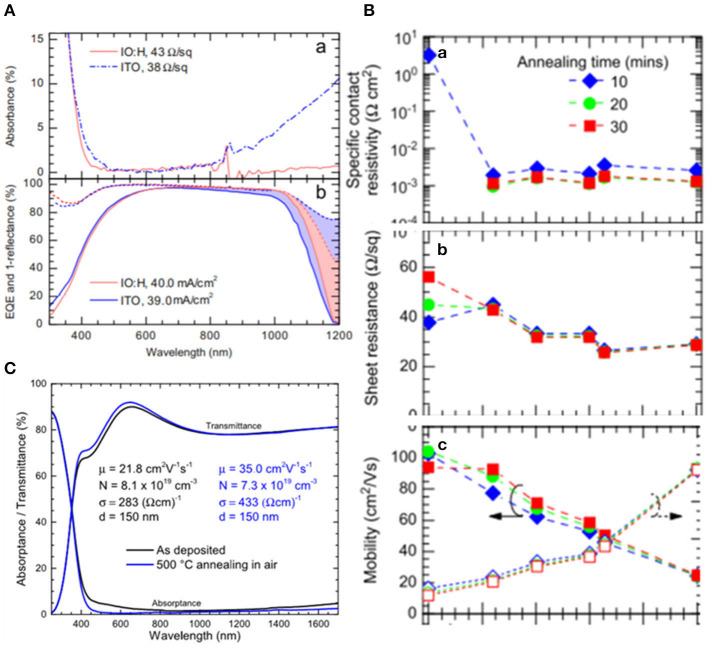
(A) Absorbance spectra, external quantum efficiency (solid), and 1-reflectance (dashed) spectra of IO:H and ITO films on glass (reproduced from ref. 10, copyright 2013, Elsevier). (B) Specific contact resistivity, sheet resistance, and mobility and free electron density of IO:H/ITO bilayers on glass (reproduced from ref. 10, copyright 2013, Elsevier). (C) UV-vis-NIR spectrophotometric of a 150 nm thick ZTO layer on glass before and after annealing at 50°C in air. Hall Effect characteristics are also given. l¼ mobility; N¼ carrier density; r¼ conductivity; and d¼ thickness (reproduced from ref. 73, copyright 2016, AIP).